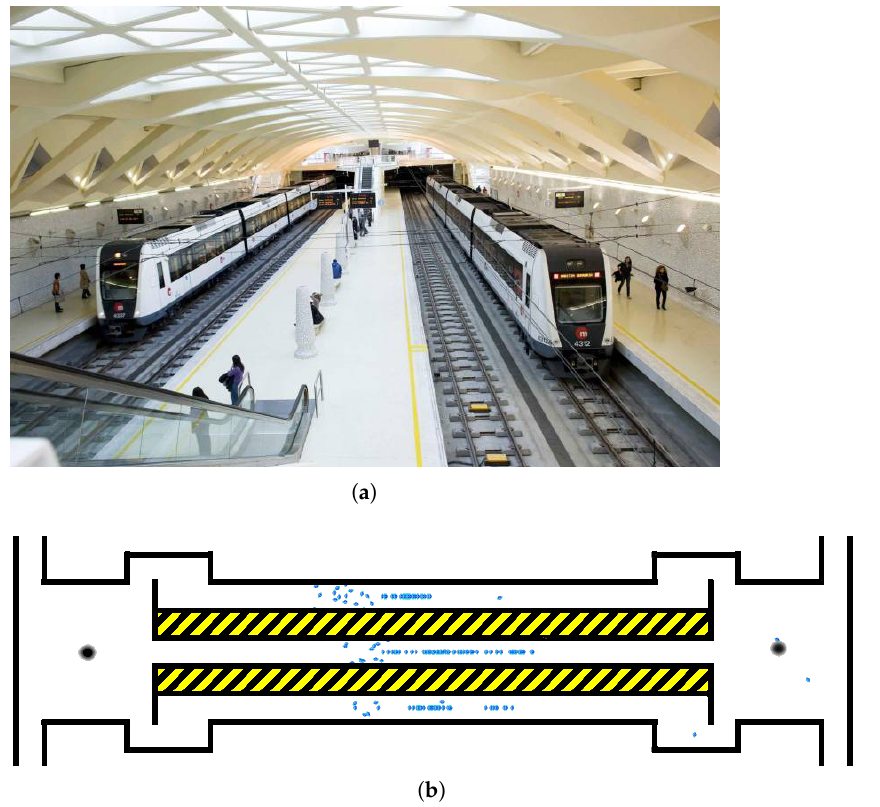
Figure 2. Alameda Station, in Valencia, ( a ) Inside view of the station. It is a subway station with four tracks and three platforms. ( b ) Scenario generated with PedSim. We can see several pedestrians entering and leaving the place (blue